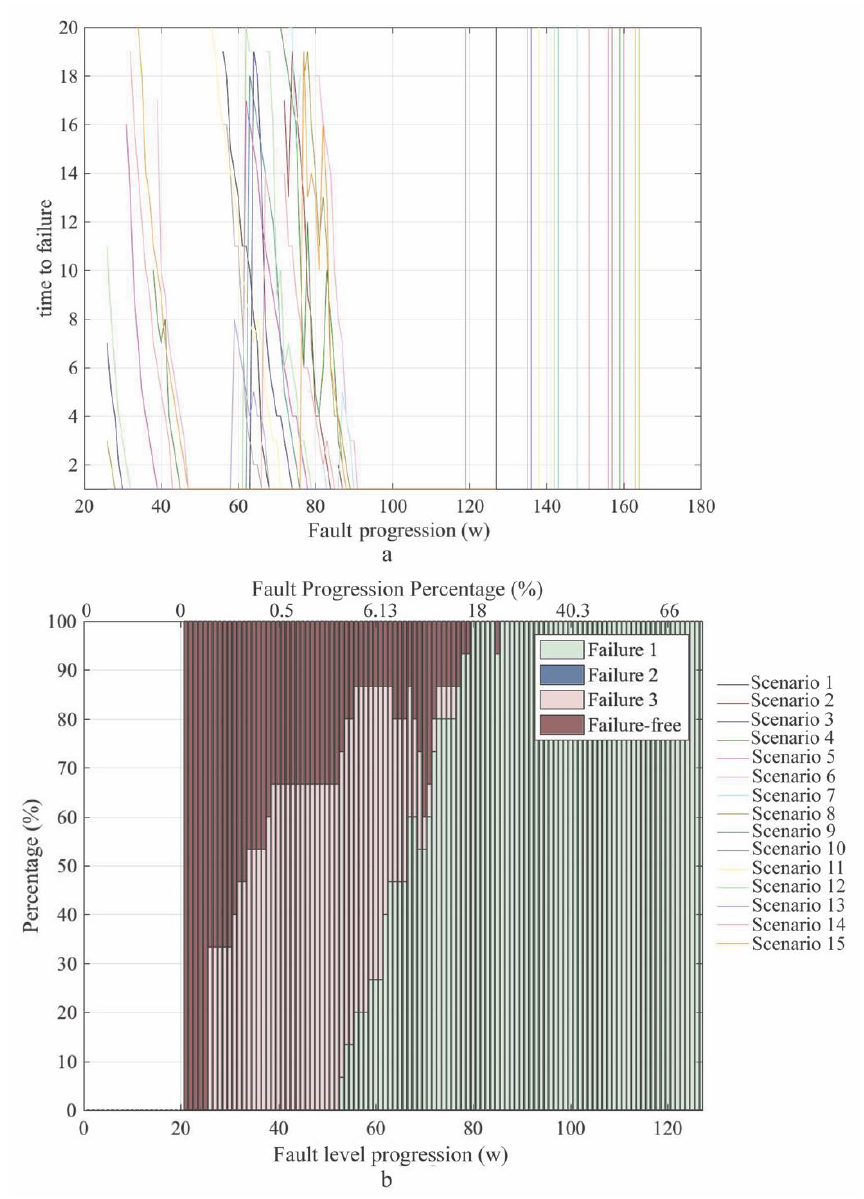
Figure 16. Failure forecasting for tank leak; ( a ) time-to-failure (TTF) of the failure mode and ( b ) forecasting of the failure